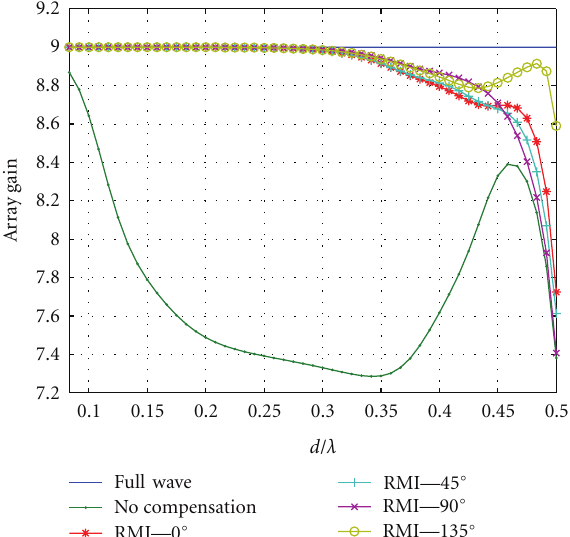
Figure 9: Array gain using the receiving mutual impedance (RMI) method as a function of the electrical separation ( d/λ ) between the elements of the nine-dipole planar array for a signal arriving from φ = 0 ◦ . Maximum gain is achieved for d/λ < 0 . 3. The performance degrades as frequency increases and becomes dependent on the excitation DOA used in the computation of the coupling matrix estimate. Nevertheless, it is superior to that of the uncompensated case for all the plotted frequencies.